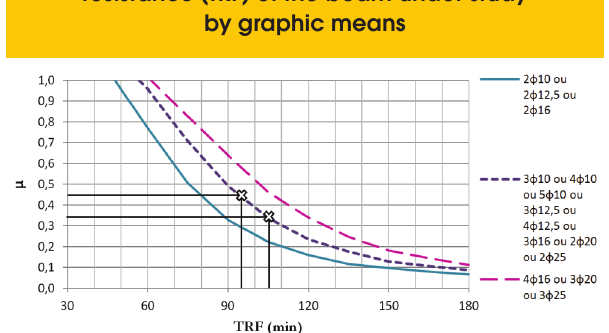
Figure 14 – Procedure for applied bending moments redistribution in fire situation